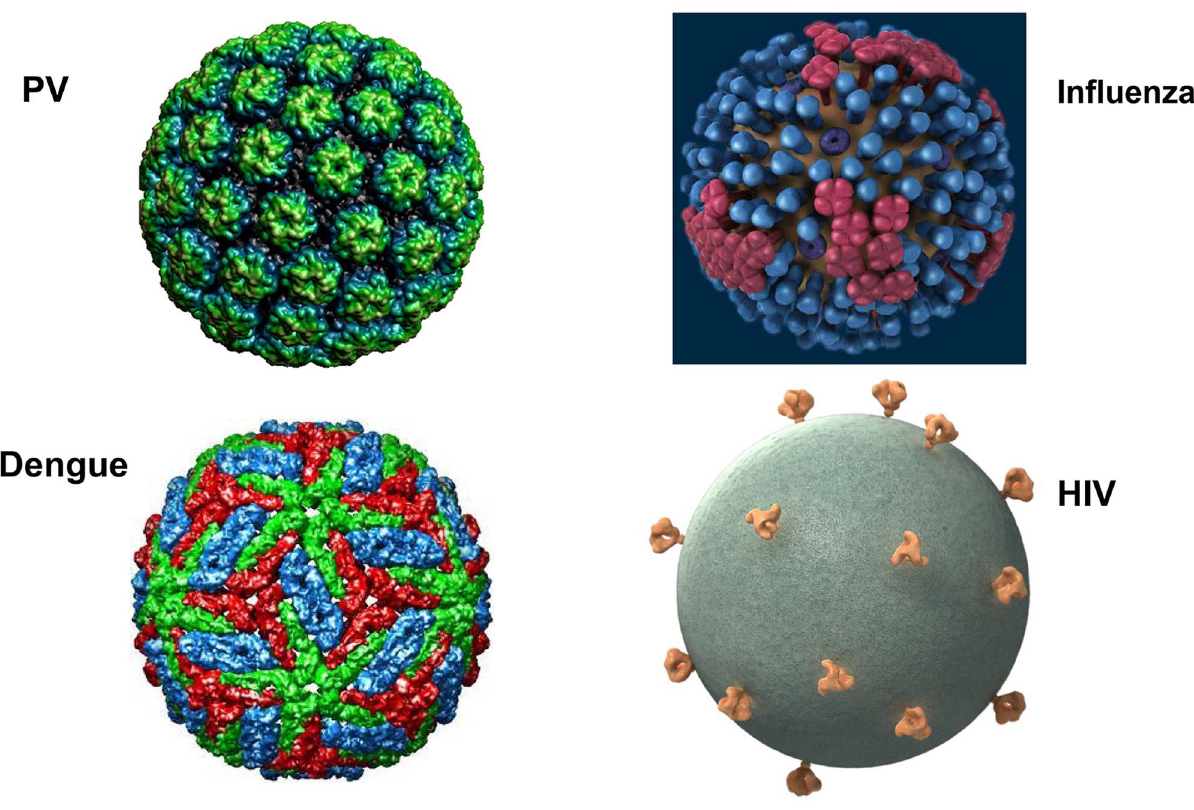
Figure 1. What’s different about HIV virions? Surface projections of bovine papillomavirus (BPV), HIV, dengue virus, and influenza virus are shown (not to scale). The images of papillomavirus (PV) and dengue virus were obtained from the Viper database (PMID: 18981051). The image of influenza virus is courtesy of cdc.gov. The HIV image was generously provided by Sriram Subramaniam, National Cancer Institute.